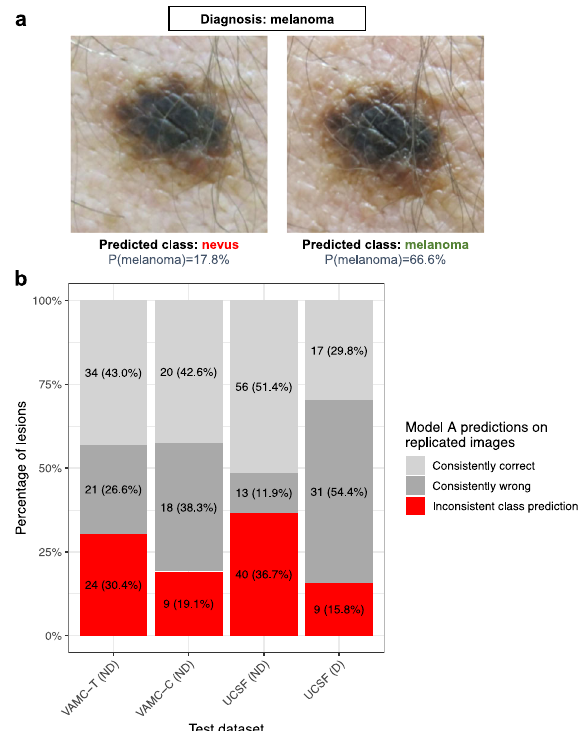
Fig. 3 Dermatologist-level CNN models are not robust across different images taken in the same setting. a Representative example of Model A predictions on different images of the same lesion taken sequentially during the same clinic session. The predicted probability of melanoma is shown below the predicted class. The decision threshold is model con fi dence >20.9%, as determined by the operating point at which the model has a sensitivity comparable to dermatologists on VAMC-T, the benchmark containing these images. b For the subset of lesions from each test dataset with replicated images, the percentage of lesions is shown grouped by whether predictions across replicated images are all correct, all wrong, or mixed. The decision thresholds are the same as those in ( a ). Only results for non-curated benchmarks are shown, as replicated images were not available for the curated